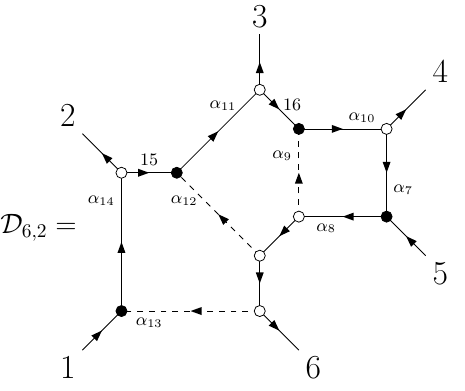
Figure 8 . On-shell diagram for a 6-point MHV amplitude. This diagram needs to be summed over all permutations of { 2 , 3 , 4 }